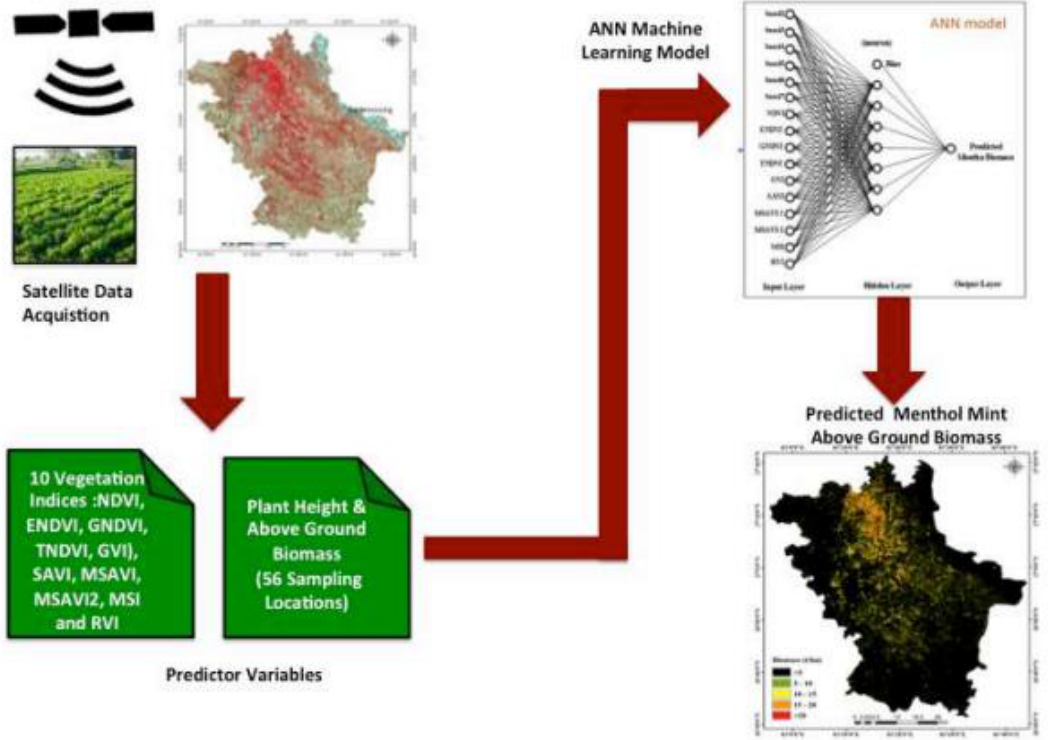
Figure 4. Overall workflow adopted, including data acquisition, mosaicking, vegetation indices, morphological features, summation of the image layers into predictor variables, and ANN machine learning regression.